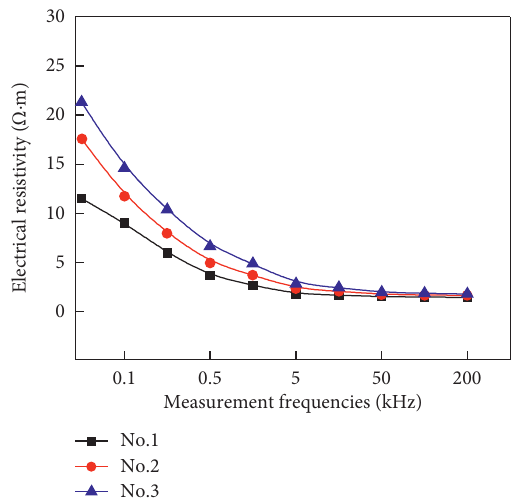
Figure 12: The electrical resistivity measurement curves of the HWBM with the W / C of